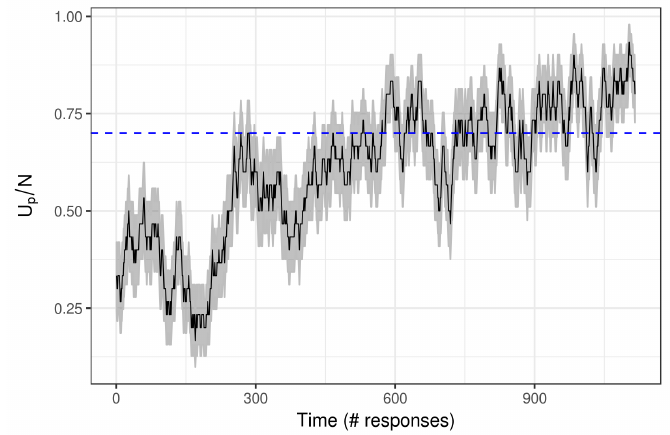
Figure 7. The average rating of players between 2015 and 2019 (Mastermind) and 2014 and 2017 (Subtraction) of children born in 2007.